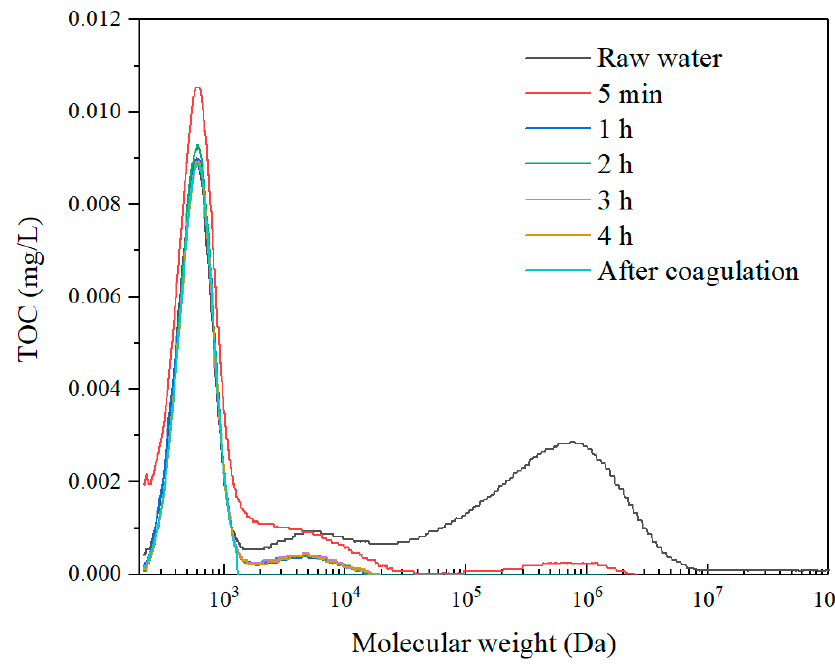
Figure 12. Molecular weight distribution (TOC detection) with a rotation speed of 30 r/min and 20 mg/L coagulant in SA solution.